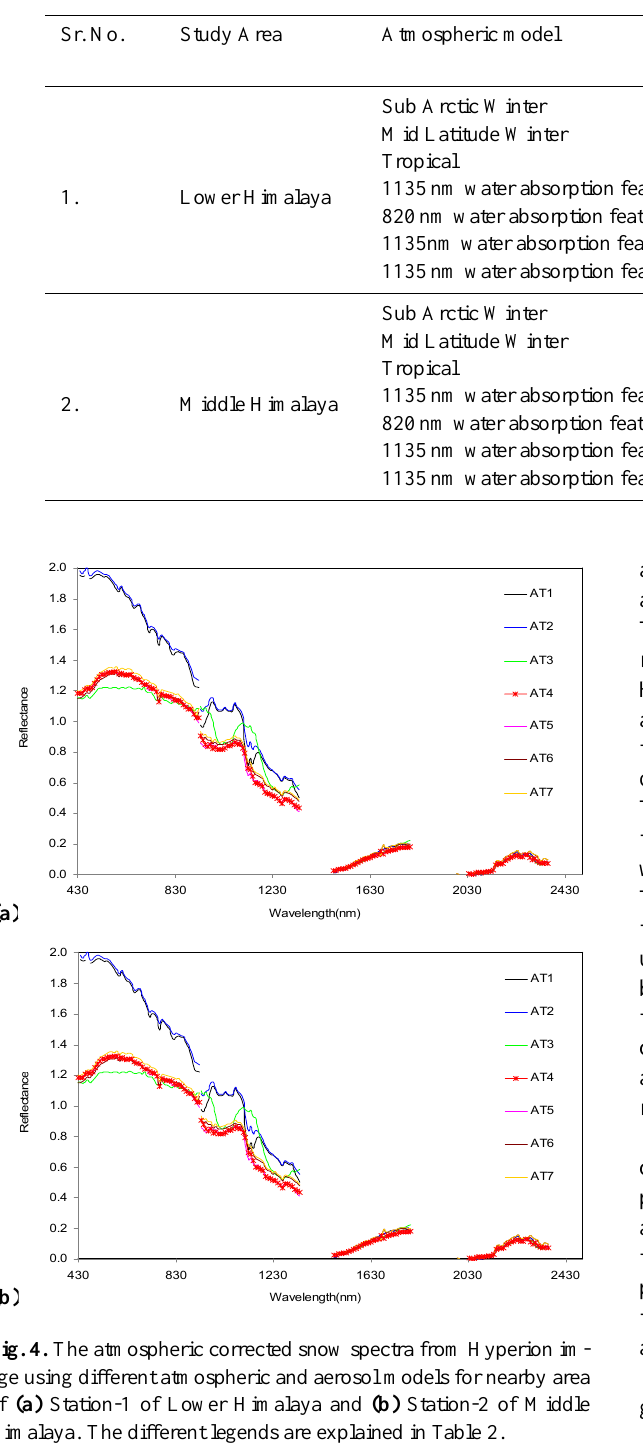
parameters that influence atmospheric absorption and scat- tering such as relative solar position, aerosol and scattering models, visibility parameters, ozone total vertical